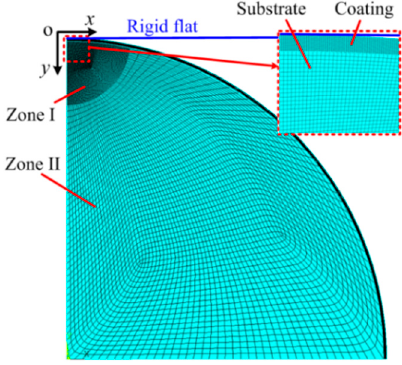
Figure 2. The two-dimensional finite element model.